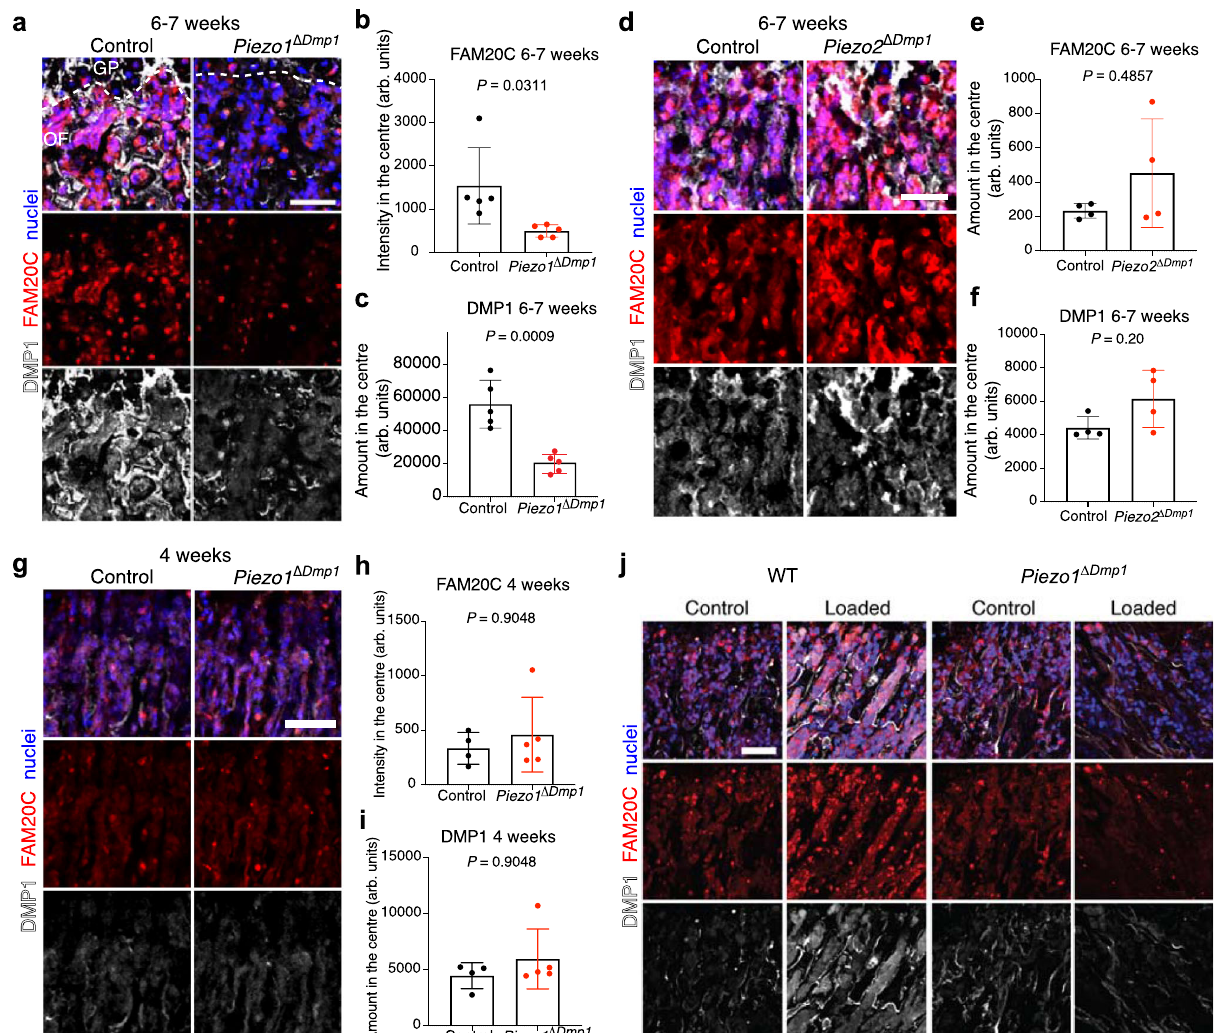
Fig. 6 Mechanoreceptor PIEZO1 drives FAM20C upregulation in osteoblasts and DMP1 secretion during periadolescence. a FAM20C and DMP1 immunostaining of 6-7-week-old control and Piezo1 Δ Dmp1 OF. Scale bar 50 µ m. b , c Quanti fi cation of FAM20C ( b ) and DMP1 ( c ) intensities in 6-7-week-old control and Piezo1 Δ Dmp1 OF. n = 5. Two-tailed unpaired t -test. d FAM20C and DMP1 immunostaining of 6-7-week-old control and Piezo2 Δ Dmp1 OF. Scale bar 50 µ m. e , f Quanti fi cation of FAM20C ( e ) and DMP1 ( f ) intensities in 6-7-week-old control and Piezo2 Δ Dmp1 OF. n = 4. Two-tailed unpaired t -test. g FAM20C and DMP1 immunostaining of 4-week-old control and Piezo1 Δ Dmp1 OF. Scale bar 50 µ m. h , i Quanti fi cation of FAM20C ( h ) and DMP1 ( i ) intensities in 4-week-old control and Piezo1 Δ Dmp1 OF. Two-tailed unpaired t -test. Mean ± SD. b , c , e , f , h , i Source data are provided in Source Data fi le. j FAM20C and DMP1 immunostaining of control and loaded (centrifuged) femur slices derived from 4-week-old Piezo1 Δ Dmp1 and Cre-negative (WT) littermate mice. Scale bar 50 µ